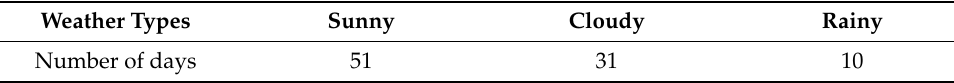
Figure 5. SSE and contour coefficient corresponding to different K value; ( a ) SSE values corresponding to different K values; ( b ) Contour coefficient corresponding to different K value. Table 3. The number of days in the weather category at K = 3.